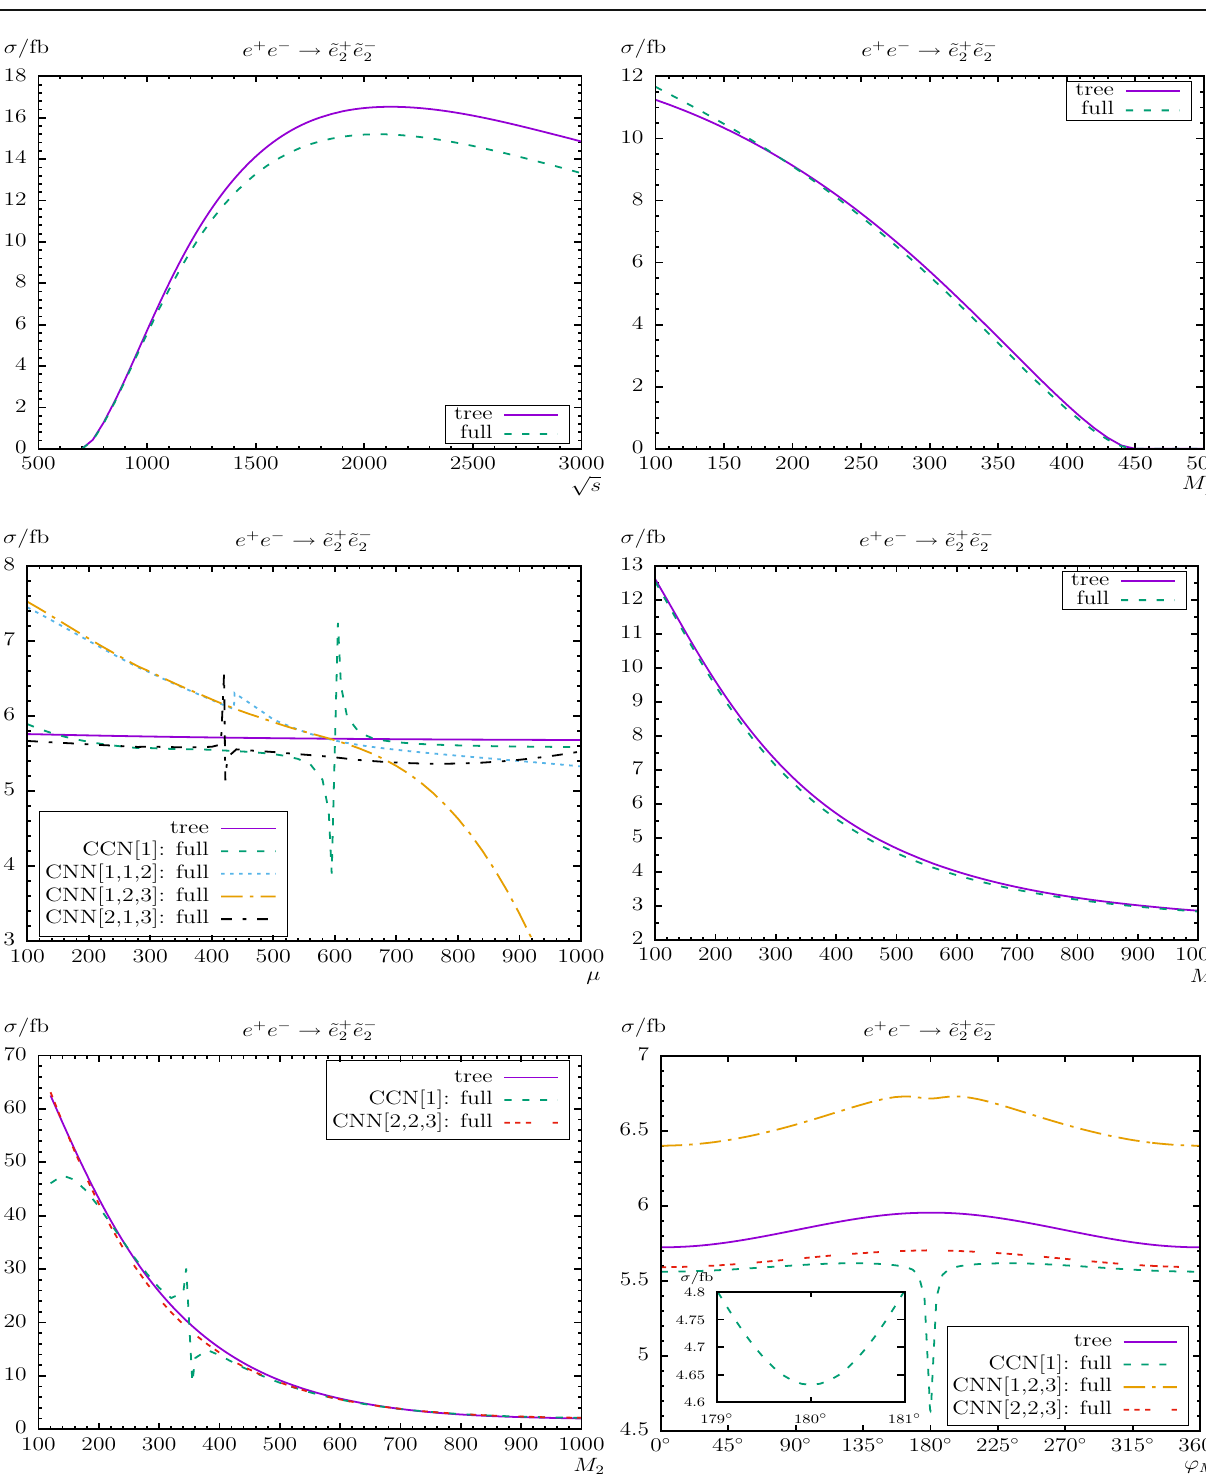
(right) varied. All masses and 1